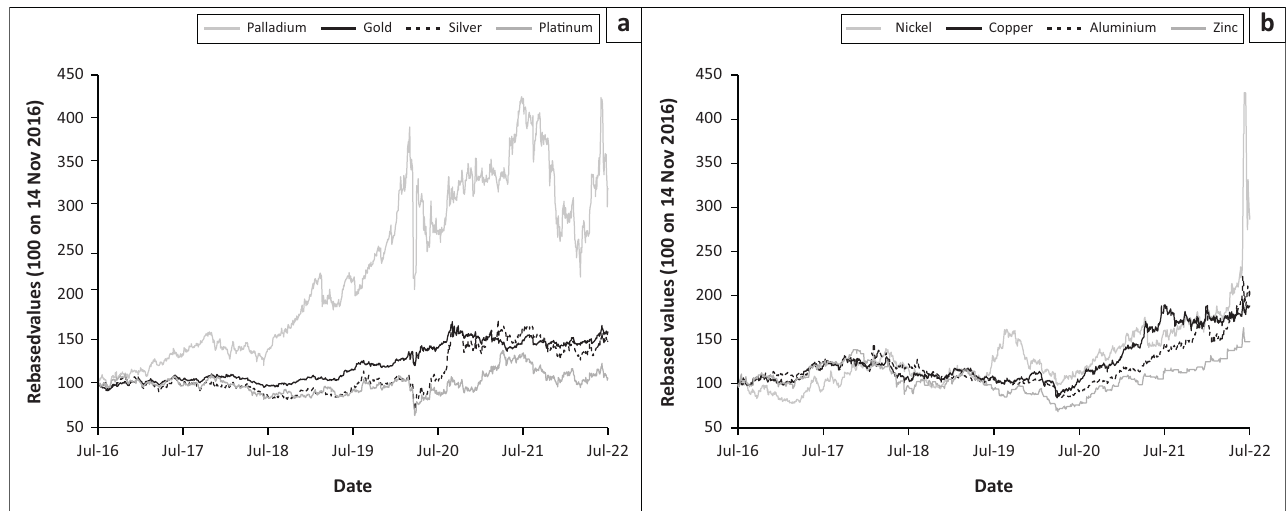
FIGURE 1: Daily prices of (a) precious (silver, gold, platinum, palladium) and (b) nonprecious ( copper, nickel, aluminium, zinc) metals between July 2016 and July 2022